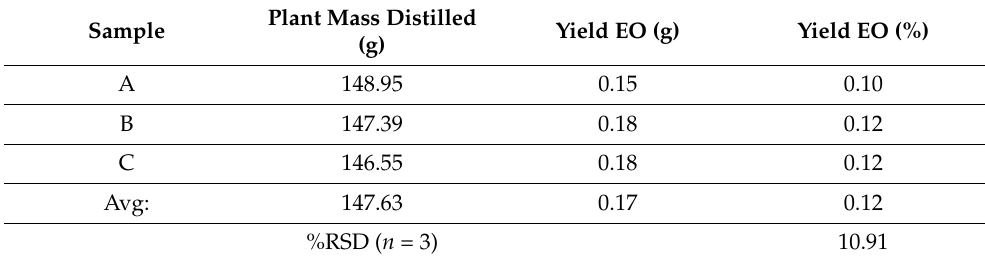
Table 1. Yield data, including mass of plant material distilled (g), essential oil yield (g), and calculated yield (%) from Osmorhiza occidentalis samples ( n =